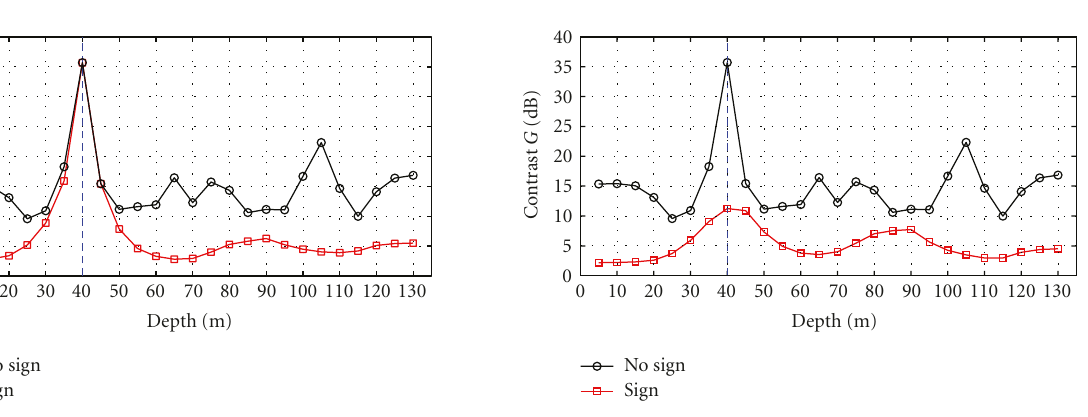
Figure 16: Contrast functions G for depth source localization by FT a approach. The results are given for methods: without mode signs (circles) and with mode signs (squares). The source is located at 40m of depth. The vertical resolution is 5m.